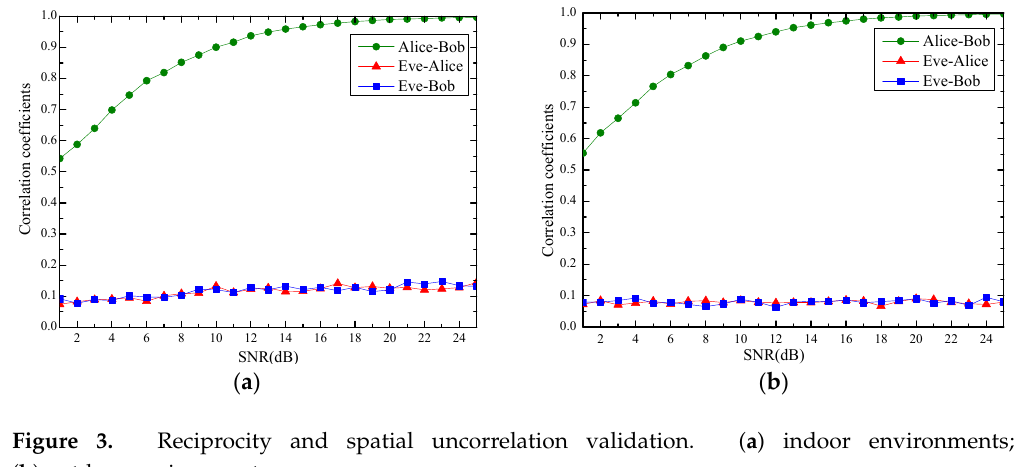
Figure 3. Reciprocity and spatial uncorrelation validation. ( a ) indoor environments; ( b ) outdoor environments.